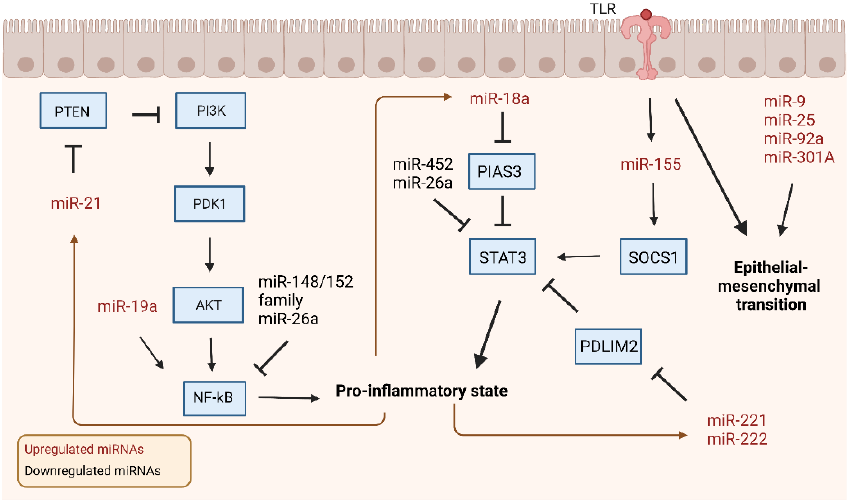
Figure 2. miRNAs involved in CAC-associated canonical signaling pathways. In the development of CAC, major signaling pathways involve the upregulation and downregulation of several miRNAs. miRNA upregulation leads to the increased expression of proinflammatory cytokines, morphological changes, and increased epithelial barrier permeability. Feedback contributes to CAC progression by further exacerbating these changes. After activation of the proinflammatory state, these associated changes go back and stimulate miRNAs to create positive feedback mechanisms. The loss of major downregulated miRNAs leads to increased proinflammatory pathway activation, leading to the compounding effects of inflammation on accelerating tumor development. Black arrow: activation. Brown arrow: positive feedback. Created with Biorender.com.